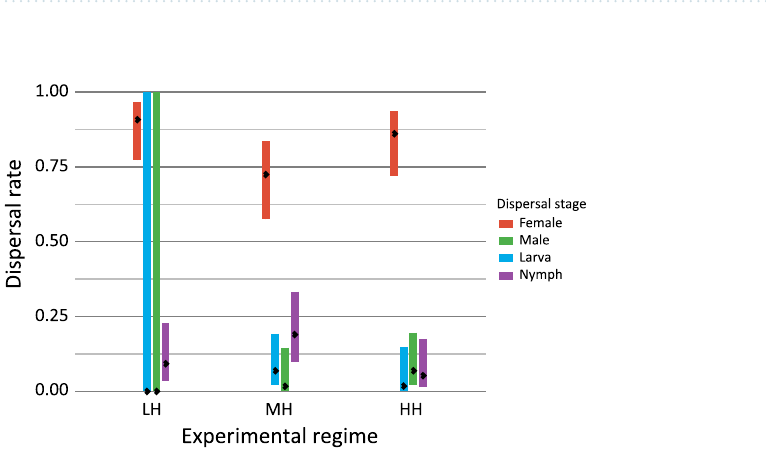
Figure 2. Mean number of mites found on infested plants in each experimental regime. Dots represent means and bars denote 95% CI.